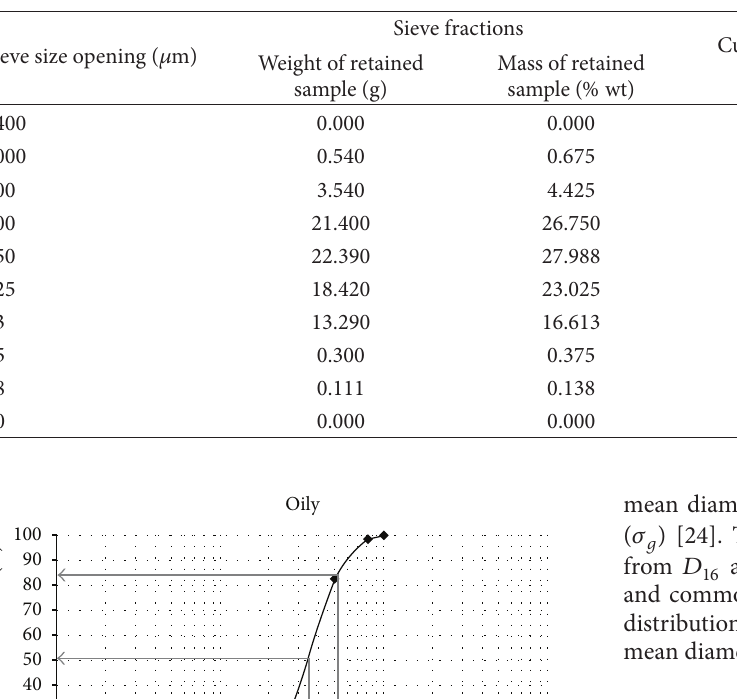
T 3: Sieve analysis results for non-oily POME sediments.